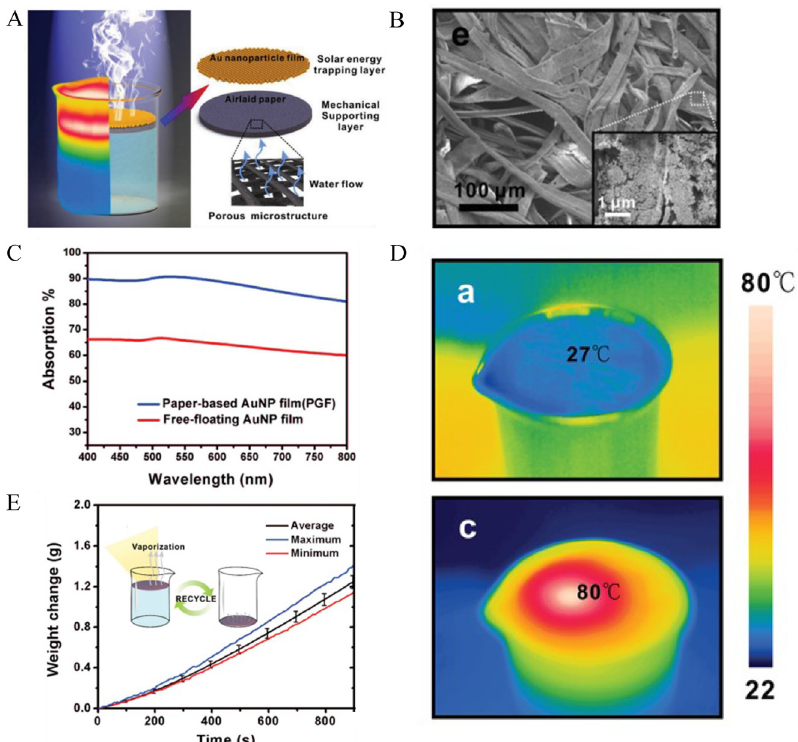
Figure 11: (A) Schematic representation of the airlaid-paper-based AuNPs (PGF). (B) The low- and high-magnification SEM images of PGF. (C) Measured absorption spectra of PGF and free-standing Au NPs film. (D) The surface temperature distributions of PGF before and after the illumination of sunlight at the power density of 4.5 kW m − 2 . The thermal images were recorded by IR camera. (E) The time- dependent maximum, minimum, and average weight changes using PGF under the illumination of sunlight [125].